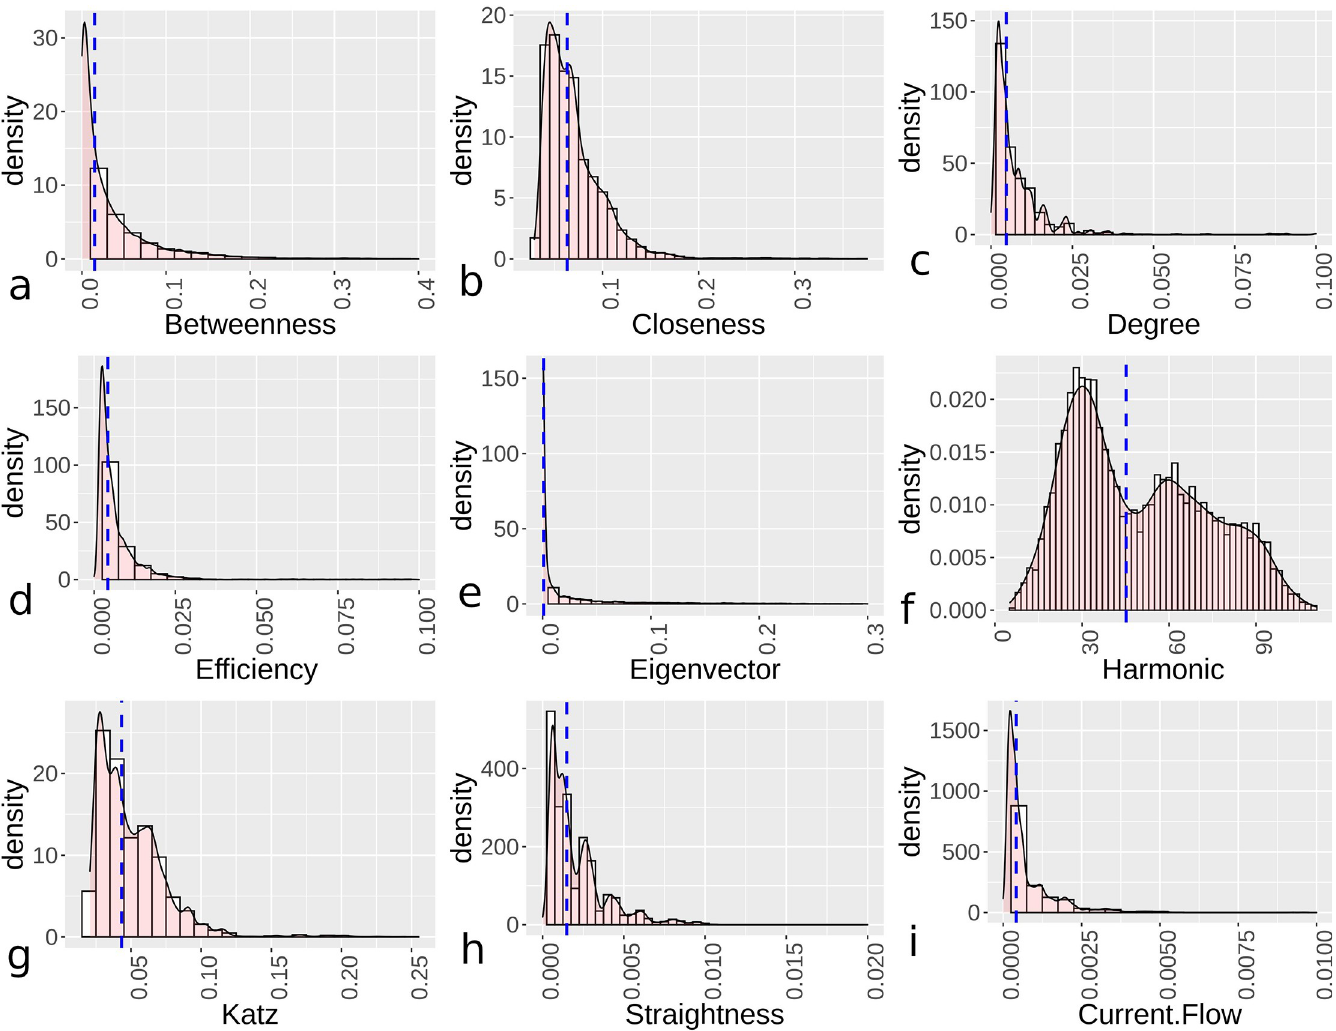
Fig 5. Kernel density plots showing centrality distributions for hybrid/organic settlements’ centrality values with the dashed lines showing median values. Graphs depict betweenness (a), closeness (b), degree (c), efficiency (d), eigenvector (e), harmonic (f), Katz (g), straightness (h), and current flow (i).